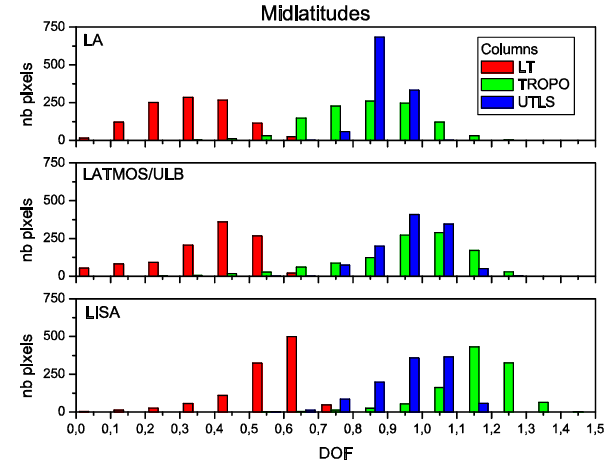
Fig. 1. Distribution of the degrees of freedom of the LT, TROPO and UTLS partial columns of ozone given over the set of pixels selected for the validation. The distribution for the LA, LATMOS/ULB and LISA products are presented in the top, middle and bottom panels, respectively.